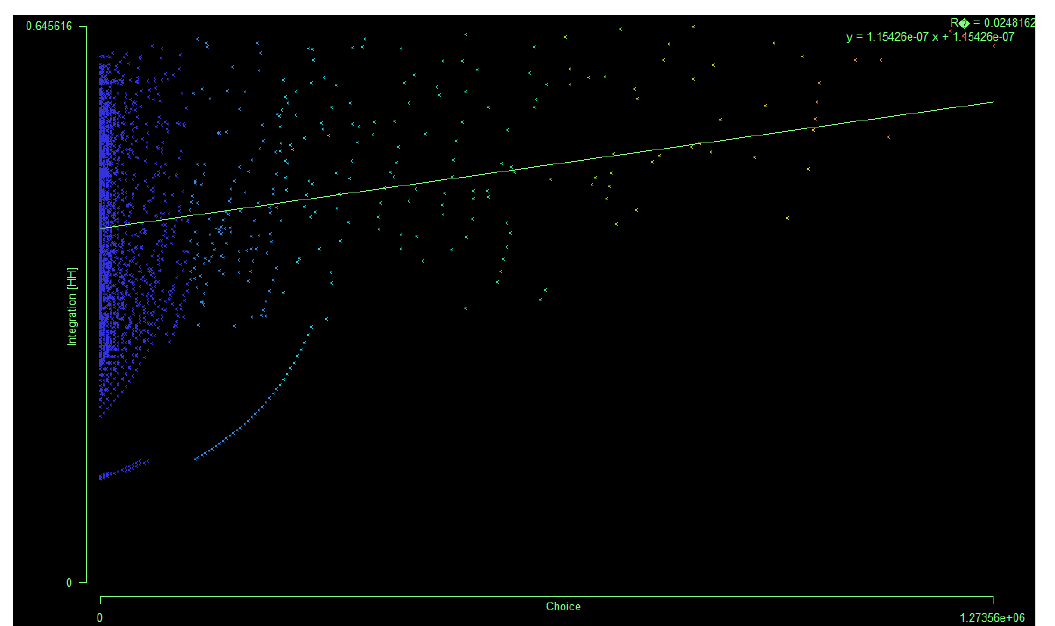
Figure 7. Accessibility: Correlation plot between choice and integration variables. “urban form” itself. The results construed from the maps of these same variables seem to indicate that the spatial organization is composed by two different urban